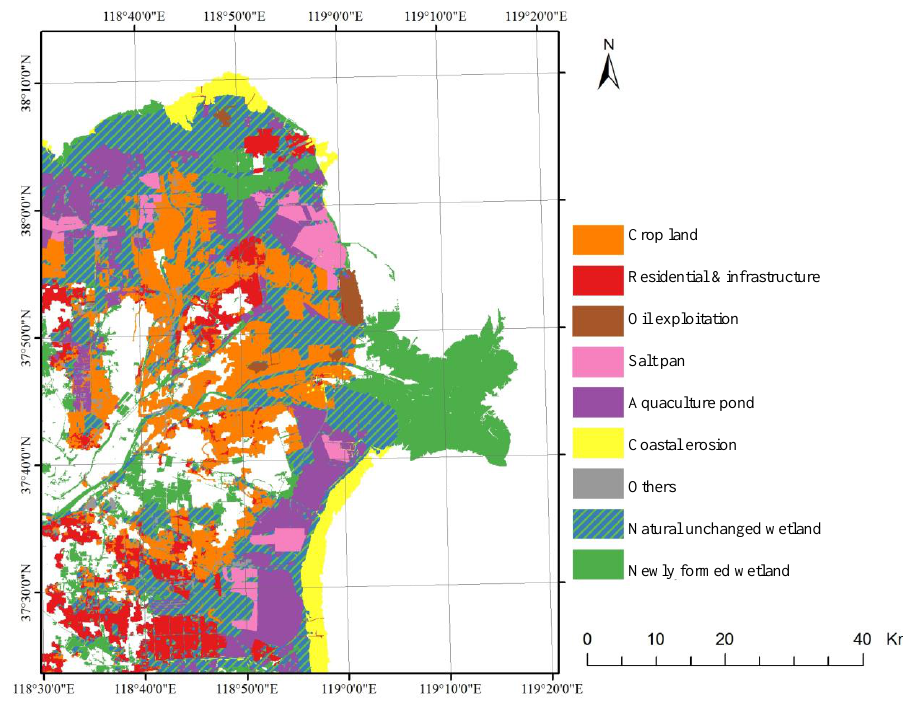
Figure 11. Changes in land use for natural wetland areas from 1973 to 2013.